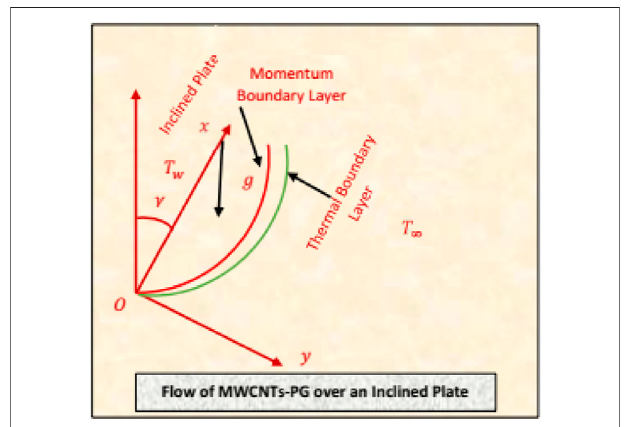
FIGURE 1 | The Flow con fi guration of MWCNTs-PG nanoliquid.